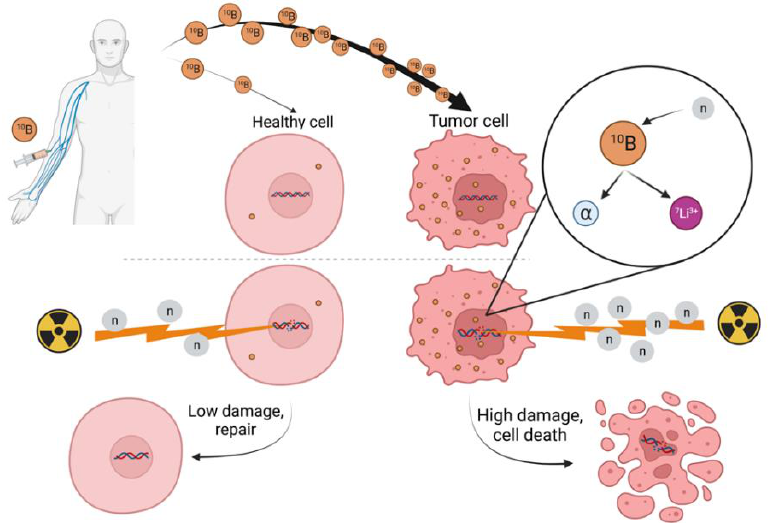
Figure 3. Schematic representation of BNCT principles of action at a cellular level. Boron accumulation is favored in tumoral cells (thick upper arrow) in comparison with normal cells (thin upper arrow).